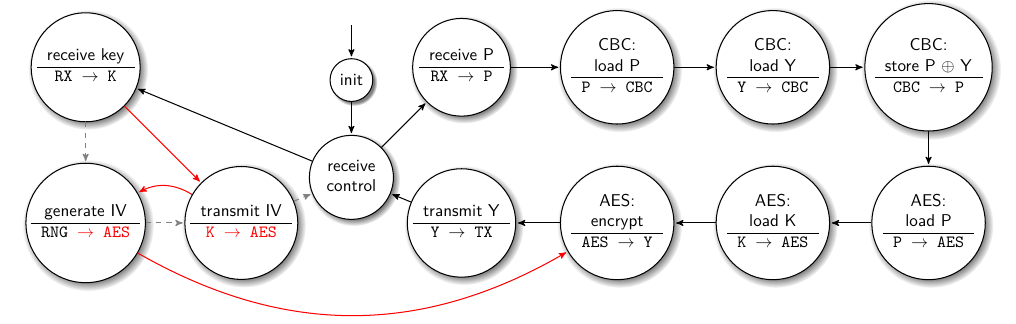
Figure 6: Overview on the realization of Evil Twin via Doppelganger. The gray transitions of the visible functionality are changed to the red ones in the hidden functionality. Likewise, bus address modifications are shown in